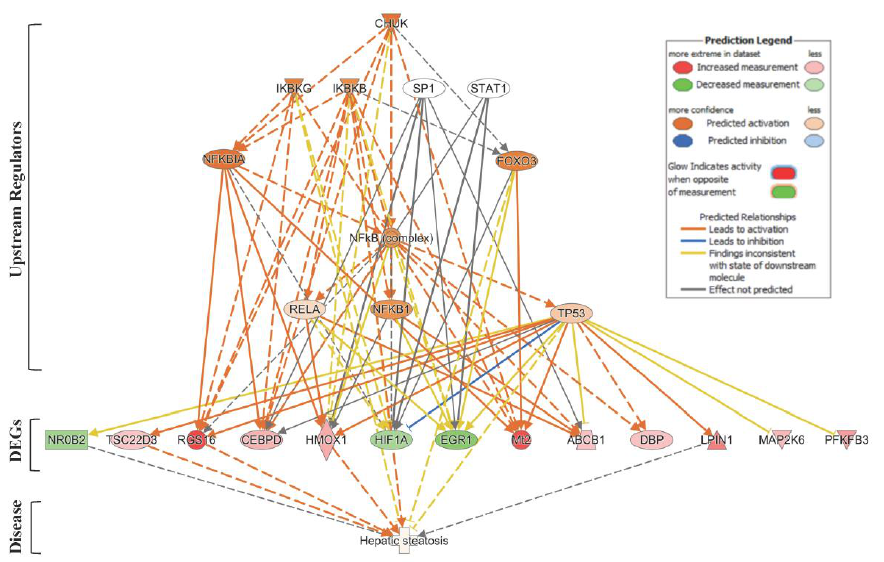
Figure 3. Upstream Regulator Analysis of lipid-specific genes in SHS-exposed mice. We used IPA ® Upstream Regulator Analysis to identify the upstream regulators that are likely to account for the aberrant expression of the 63 lipid-specific genes in SHS-exposed mice. Using IPA ® prediction analysis, we found that 25 out of the 63 lipid-specific genes are likely to be modulated by a complex network of eleven upstream regulators. For brevity, only gene targets regulated by TP53 are shown. Red molecule, up-regulation; green molecule, down-regulation. Solid and dotted lines indicate a direct or indirect relationship, respectively, between the upstream regulator and its target.